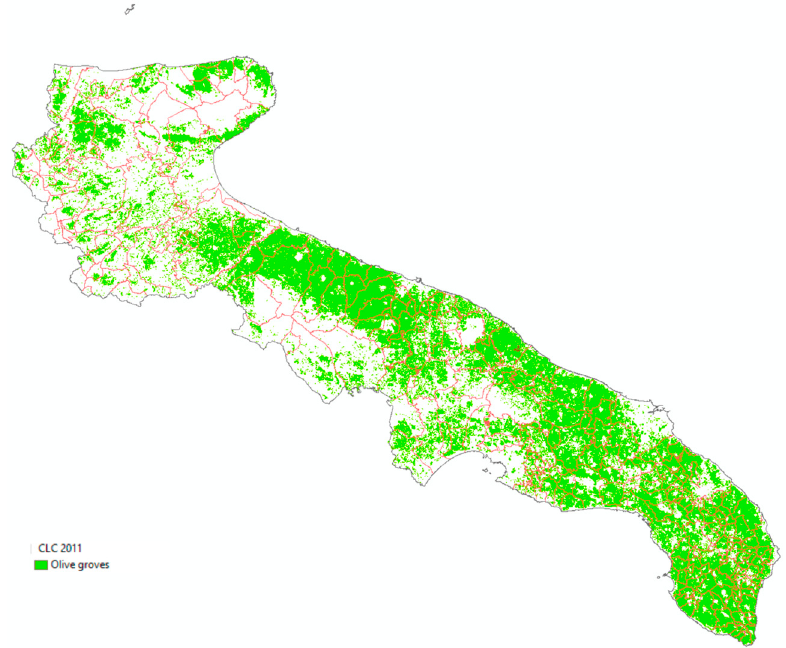
Figure 2. Olive groves in the Apulia region (Corine land cover